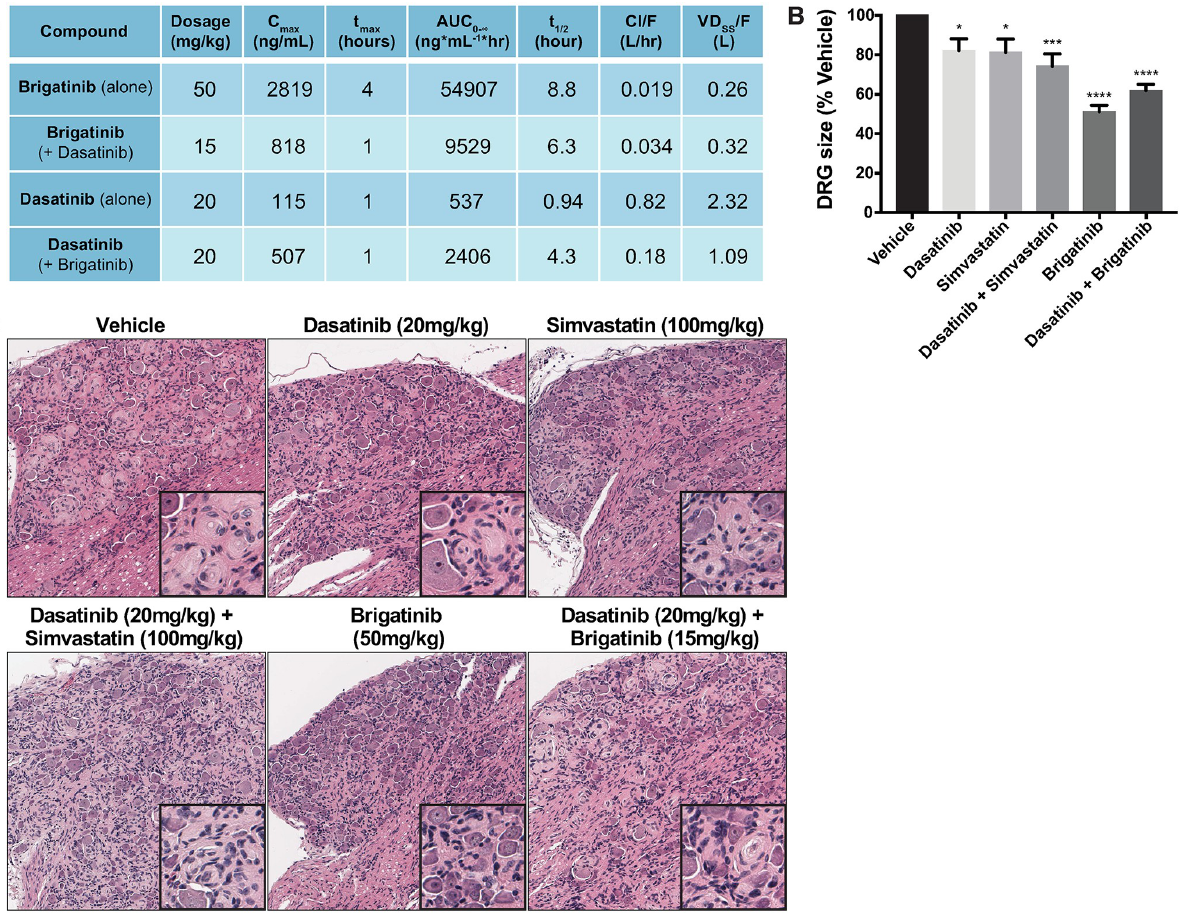
Fig 6. Brigatinib, dasatinib, simvastatin and combination treatments in the schwannoma mouse model. (A) Single-dose pharmacokinetics of compounds in PostnCre; Nf2 flox/flox mice. Plasma compound concentrations were measured at baseline, 1, 2, 4, 8 and 24 hours after administering a single oral dose to n = 3 PostnCre; Nf2 flox/flox mice. Parameters were calculated using a noncompartmental NCA-xls using PK add ins. (B) Volume of dorsal root ganglia (DRG) was measured post-mortem. All treatment groups had significantly smaller DRG volume when compared to vehicle, and brigatinib-treated DRGs showed the greatest reduction. One-Way ANOVA with Dunnett’s multiple comparison’s test; p = 0.0001( ���� ), p = 0.0007 ( ��� ), p < 0.05( � ). (C) Representative hematoxylin and eosin stained DRGs following 12 weeks of continuous treatment with the indicated drugs.